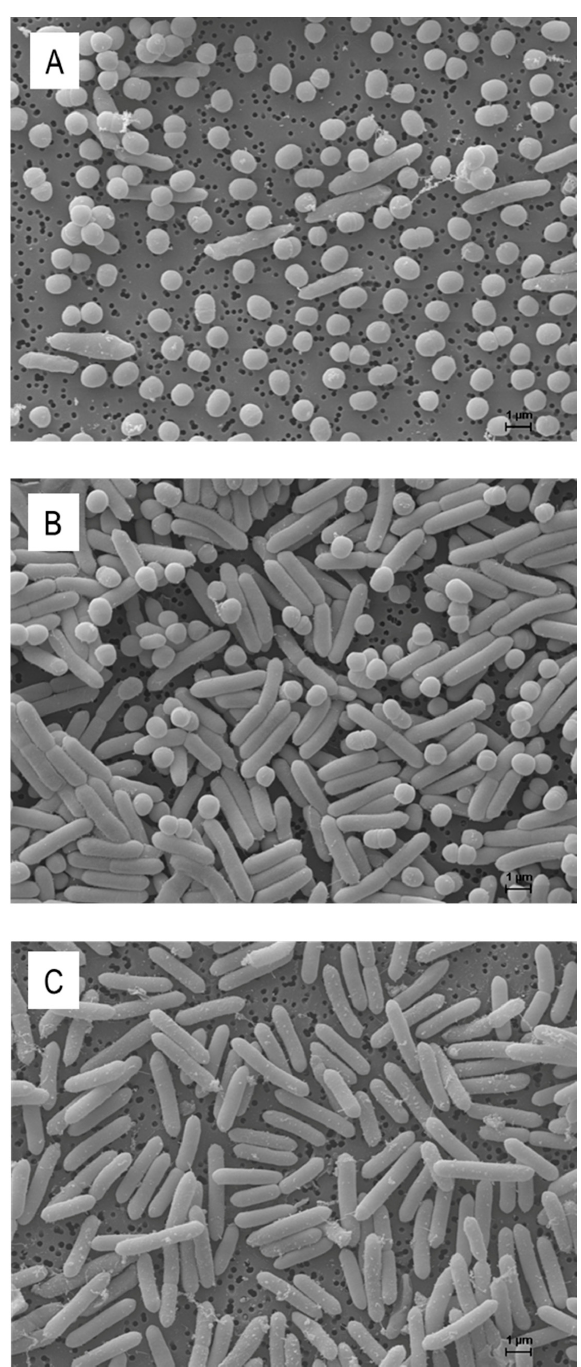
Figure 3. Scanning electron micrographs of Arthrobacter citreus and Paenibacillus apiarius grown in co-culture within DNB for 1 h ( A ) and for 16 h ( B ) as well as the pure culture of Paenibacillus apiarius after 16 h of cultivation ( C ). Scale bar = 1 µm.